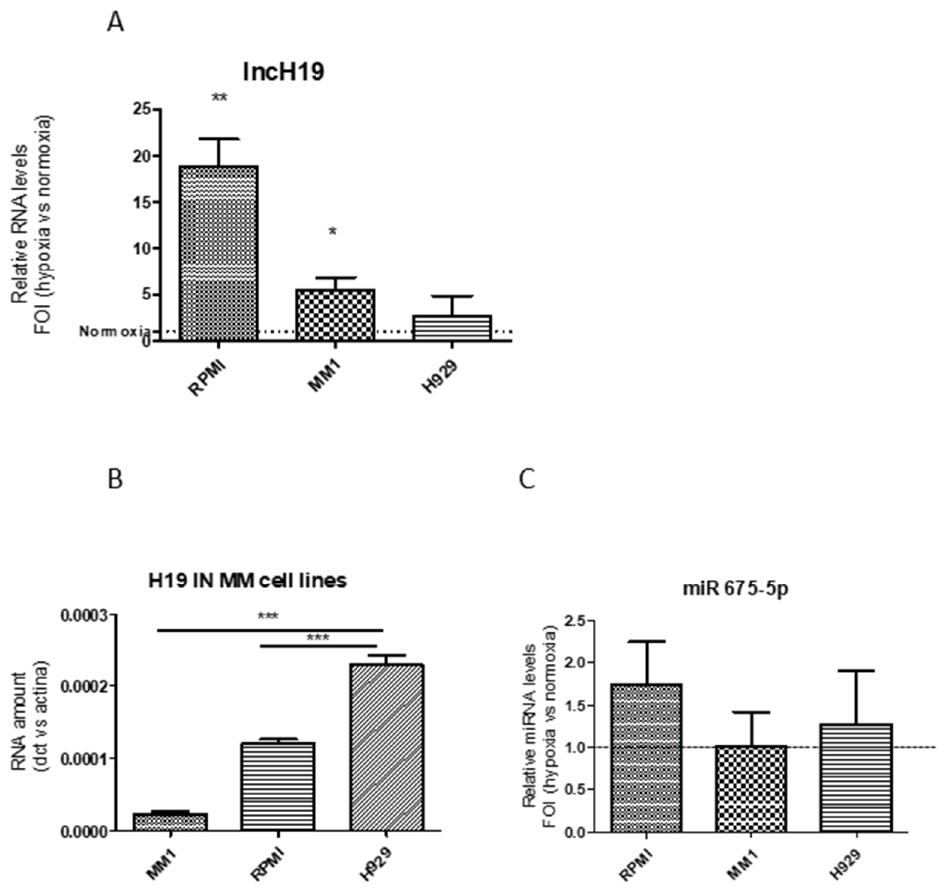
Figure 1. qRT-PCR indicate long non coding H19 (lncH19) levels in Multiple Myeloma (MM) cell lines after 24-h hypoxic stimulation expressed as fold of induction versus lncH19 levels in normoxia. Statistical analysis was performed by the use of student t-test; * p < 0.05; ** p < 0.01 ( A ). qRT-PCR indicate the basal level of the lncH19 in normoxic MM cell lines. Statistical analysis was performed by the use of one way ANOVA test and Dunnett’s multiple comparison test; *** p = 0.001 ( B ). qRT-PCR indicate the levels of miR-675-5p in MM cell lines after 24-h hypoxic stimulation expressed as fold of induction versus normoxia ( C ). Values are presented as mean ± SD.